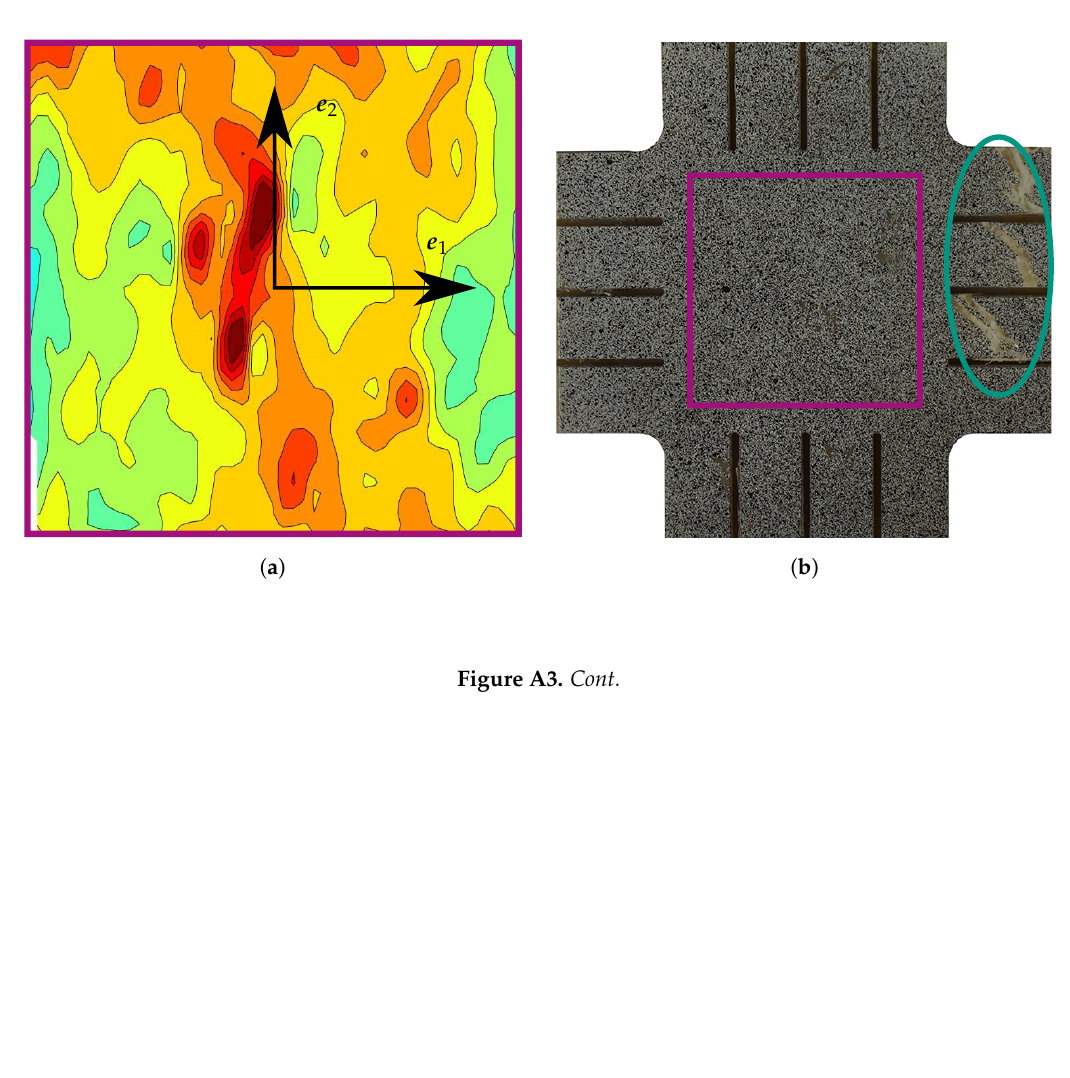
Figure A2. Unreinforced specimen arms. Last image of strain field before failure and failed specimen. ( a ) strain field ε 11 in A I for load case P Γ = 0 ; ( b ) failed specimen for load case P Γ = 0 ; ( c ) strain field ε 11 in A I for load case P Γ = 1 ; ( d ) failed specimen for load case P Γ = 1 .